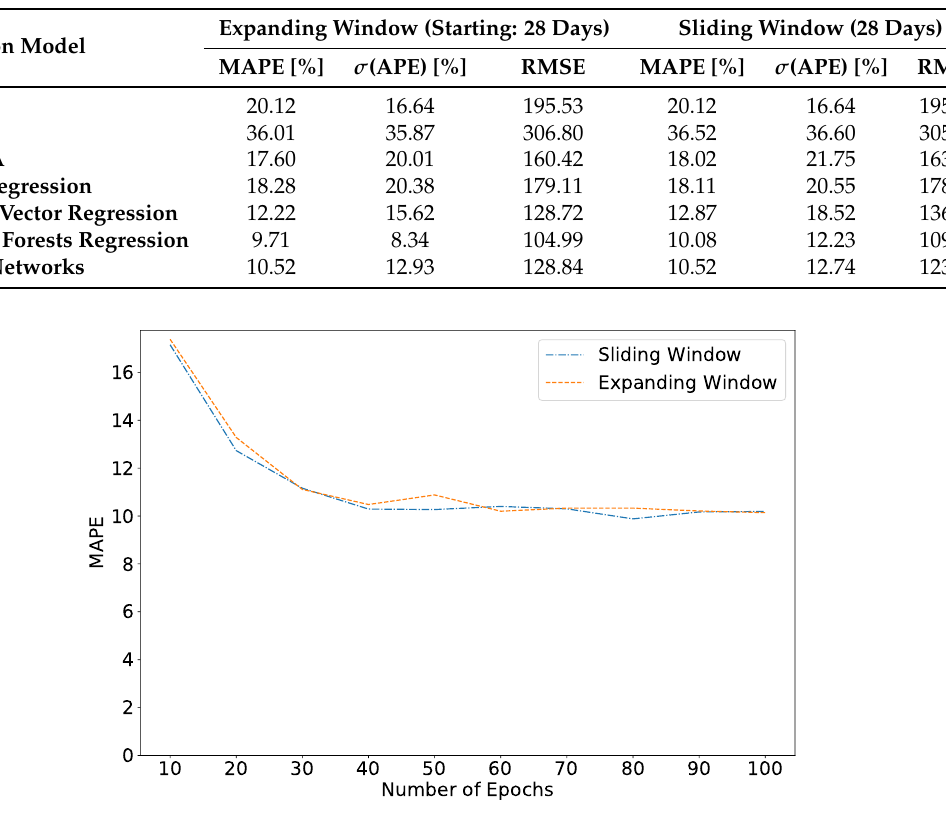
Figure 8. Effect of the number of epochs on the performance (MAPE) of the Neural Networks model.